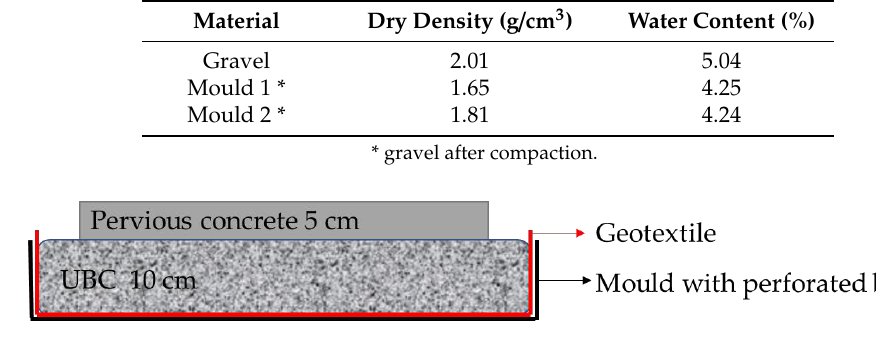
Figure 3. Test setup for pervious concrete-unbound base layer system drainage testing.